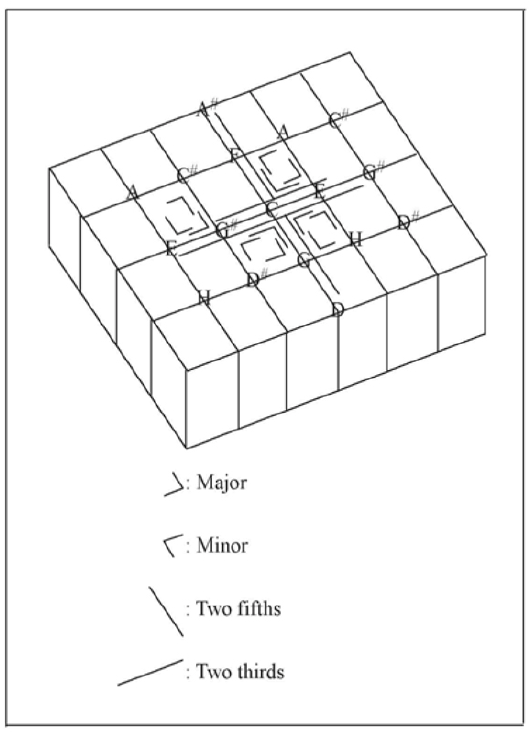
FIGURE 12. The theoretical possibilities for fifth-third interval jumps in the reduced complex overtone